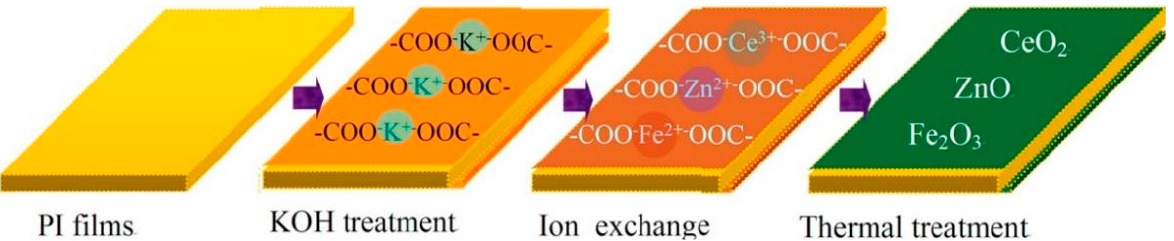
Figure 14. Schematic process of the PI-based CeO 2 –Fe 2 O 3 –ZnO mixed oxide preparation. Reprinted with permission from Ref. [136]. 2018, Elsevier.